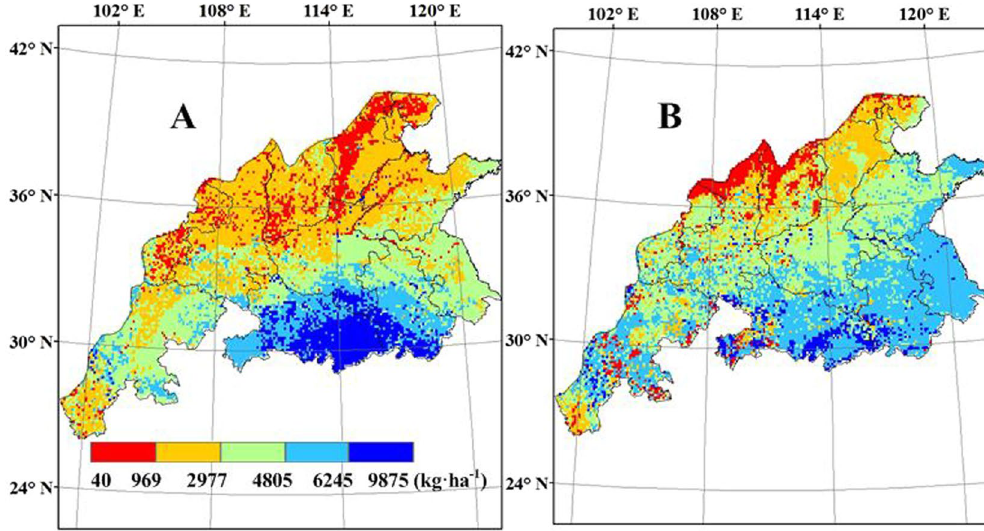
Figure 10. Spatial distribution of average simulated rainfed yield of winter wheat from 1998 to 2008 in the main production regions of China, ( A ) CERES-Wheat; ( B ) WheatGrow (This figure was created by ArcGIS 9.3, http://www.esri.com/arcgis/).